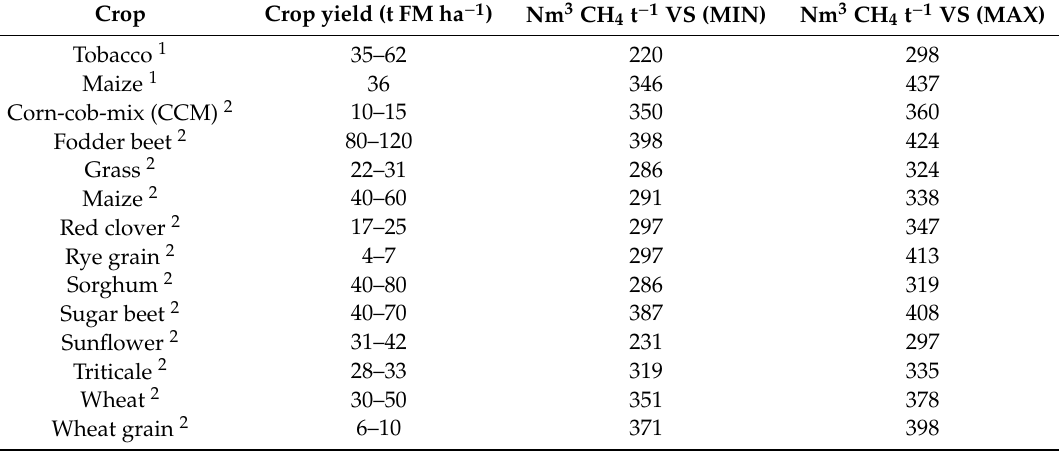
Table 5. Gross crop yield (fresh) and methane potential of di ff erent